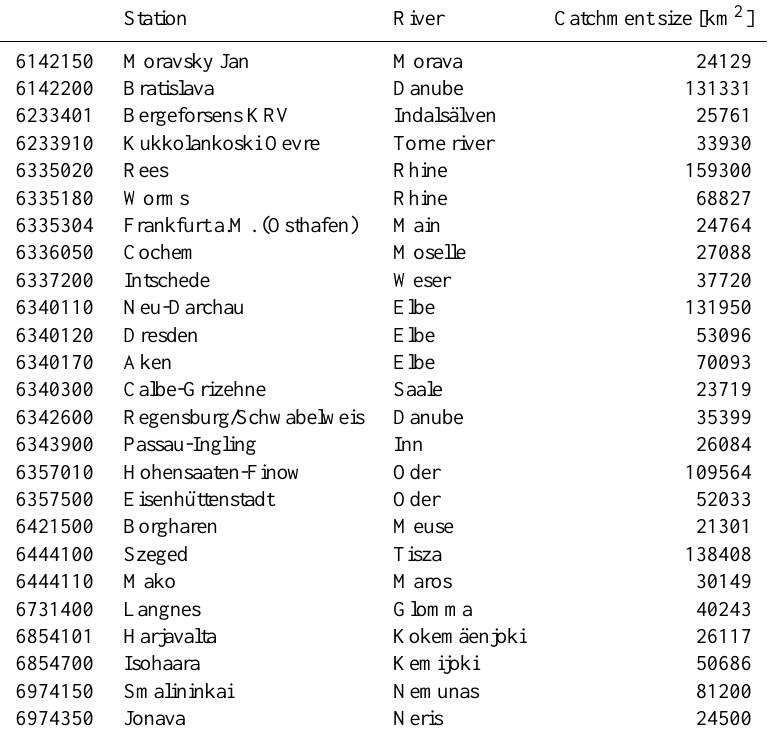
Table 1. GRDC gauging stations used for